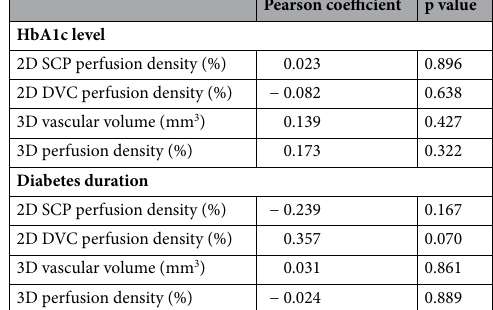
Table 2. Correlation analysis between OCTA parameters and other variables (i.e. HbA1c level and diabetes duration). HbA1c hemoglobin A1c, OCTA optical coherence tomography angiography, 2D two-dimensional, 3D three-dimensional, SCP superficial capillary plexus, DVC deep vascular